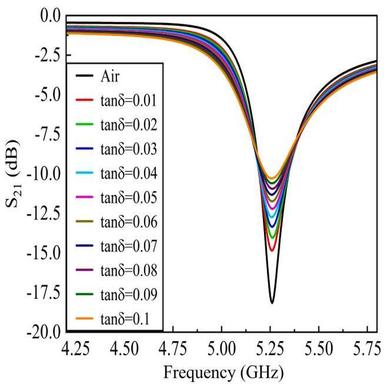
Simulation result of the sensor for variation of tanδ with steps of 0.01.